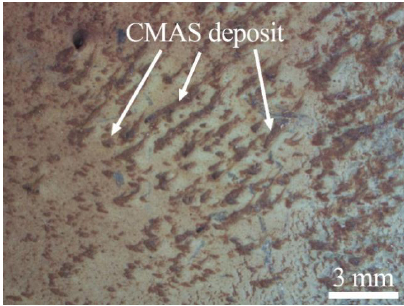
Fig. 48 Optical image showing the appearance of CMAS deposits on an ex-service